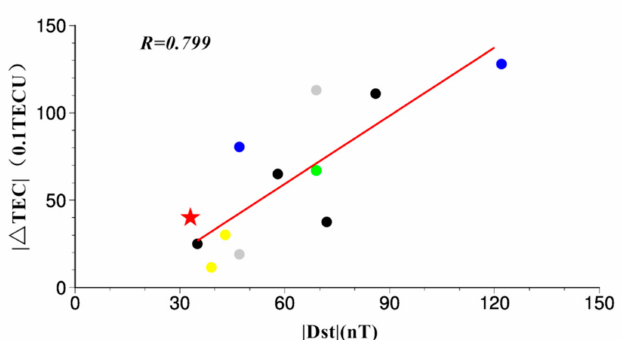
Figure 8. Positive correlation between | ∆ TEC | and | Dst | from April 2012 to March 2013, where the black, green, grey, yellow, and blue dots represent the time of 16–19 June, 15 July, 2–3 September, 1–2 October, and 29–30 November 2012 and the pentagram represents the time of period-3.